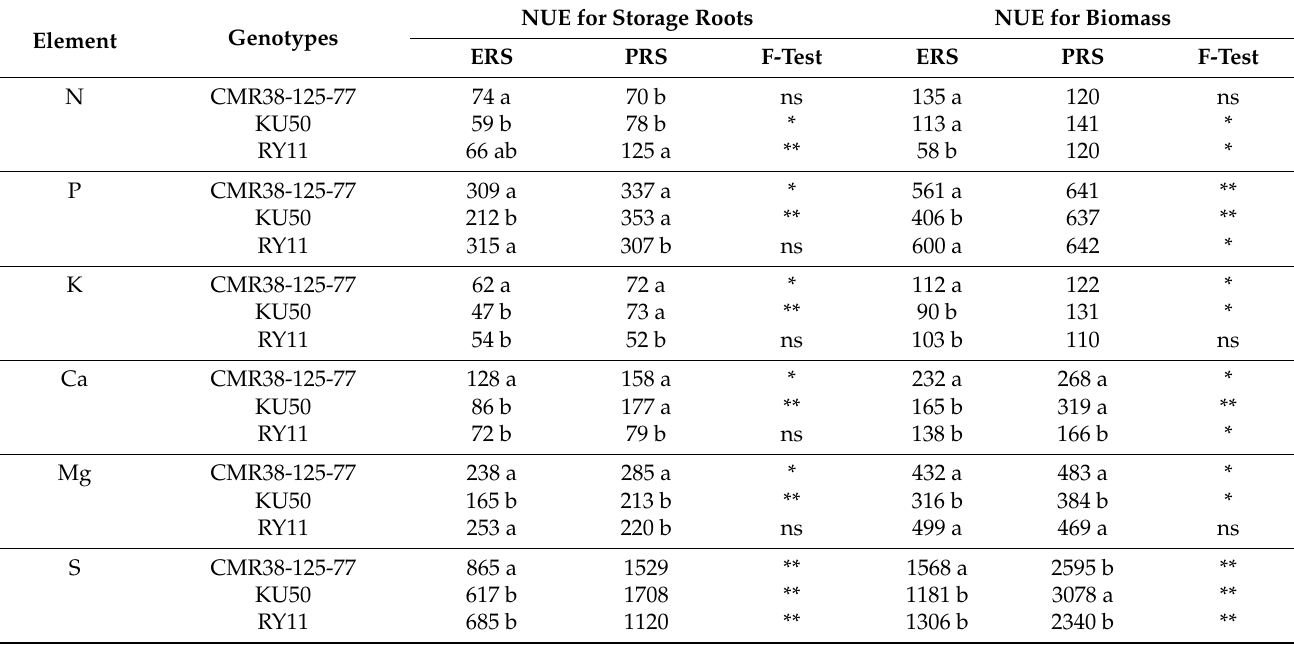
Table 6. Nutrient use efficiency (NUE) for the storage roots and biomass of three cassava genotypes at 12 MAP in the early rainy season (ERS) and post rainy season (PRS) with full irrigation. Element